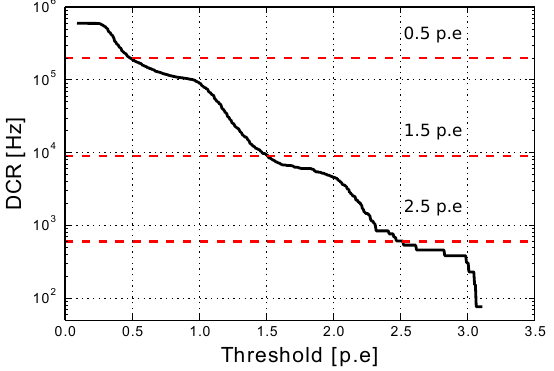
Figure 8. Dark count rate as a function of the detection threshold. The curve shape presents three breaks at 1pe, 2pe and 3pe because of the discretization effect on the pulse amplitude.